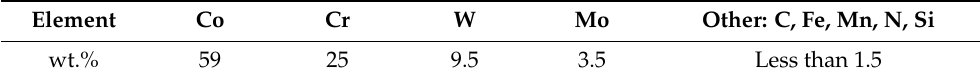
Table 1. Chemical composition of the metallic powder. Element Co Cr W Mo Other: C, Fe, Mn, N, Si